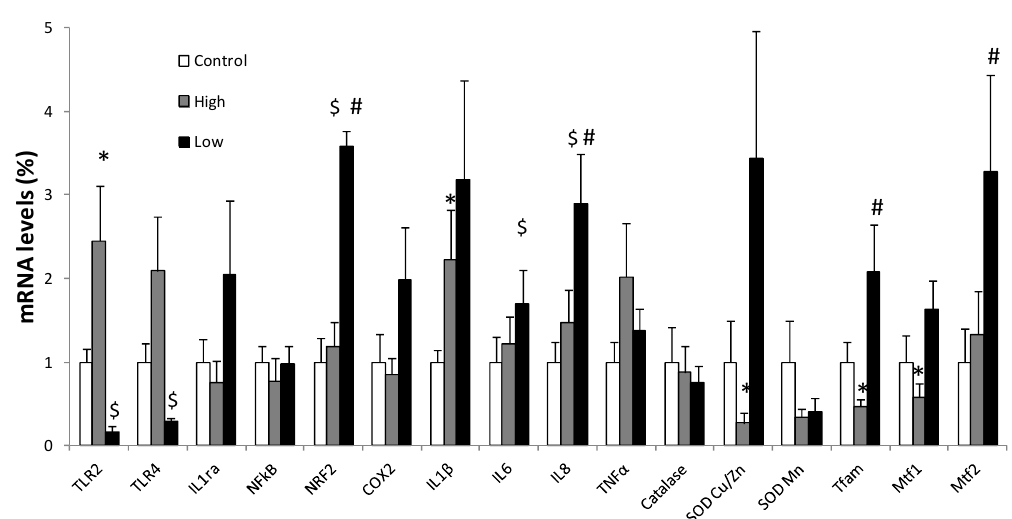
Figure 4. Relative gene expression of pro/anti-inflammatory proteins, antioxidant enzymes and mitochondrial dynamics related proteins in PBMCs. Ribosomal 18S as a reference. Control was arbitrarily referred to as 1. (Control: only cells present in the medium; high: 1 µ g solid GOX/mL; low: 0.1 µ g solid GOX/mL). Statistical analysis: Student’s t-test for paired data, p < 0.05. (*) Significant effects between the high treatment and the control; ($) significant effects between the low treatment and the control; (#) Significant effects between the high treatment and the low treatment.